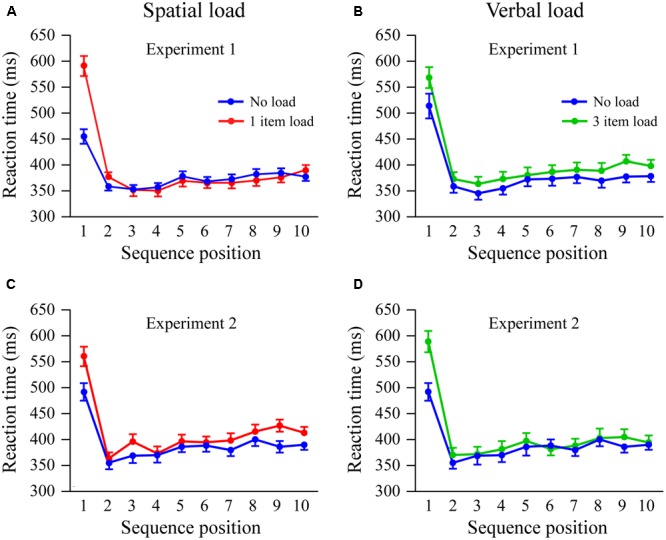
Task switching effects under spatial (A,C) and verbal (B,D) load. Experiment 1 results are shown in the first row, with Experiment 2 findings in the second row. Sequence indicates serial position of the 10 stimuli in the attention task. Reaction times to the first stimulus after memory encoding were significantly longer relative to subsequent stimuli. Short-term memory load significantly increased reaction times to the first stimulus. Error bars indicate 1 SEM.